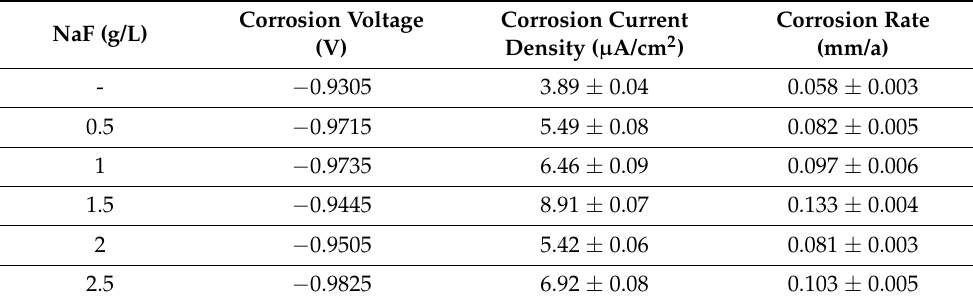
Table 1. The results of the polarization curves of MAO coating with different NaF